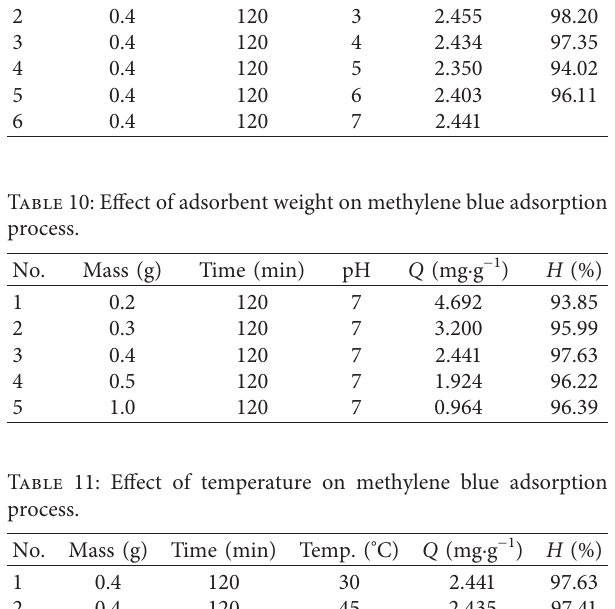
Table 9: Effect of pH on methylene blue adsorption process. No. Mass (g)